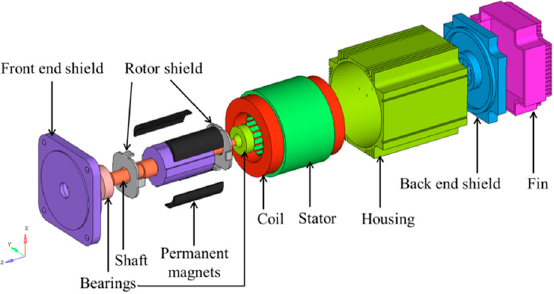
Figure 2. 3-D entire geometry of the BLDC motor including stator core, rotor, rotor housing, perma- nent magnets, stator housing, fin, coil, and other various components.